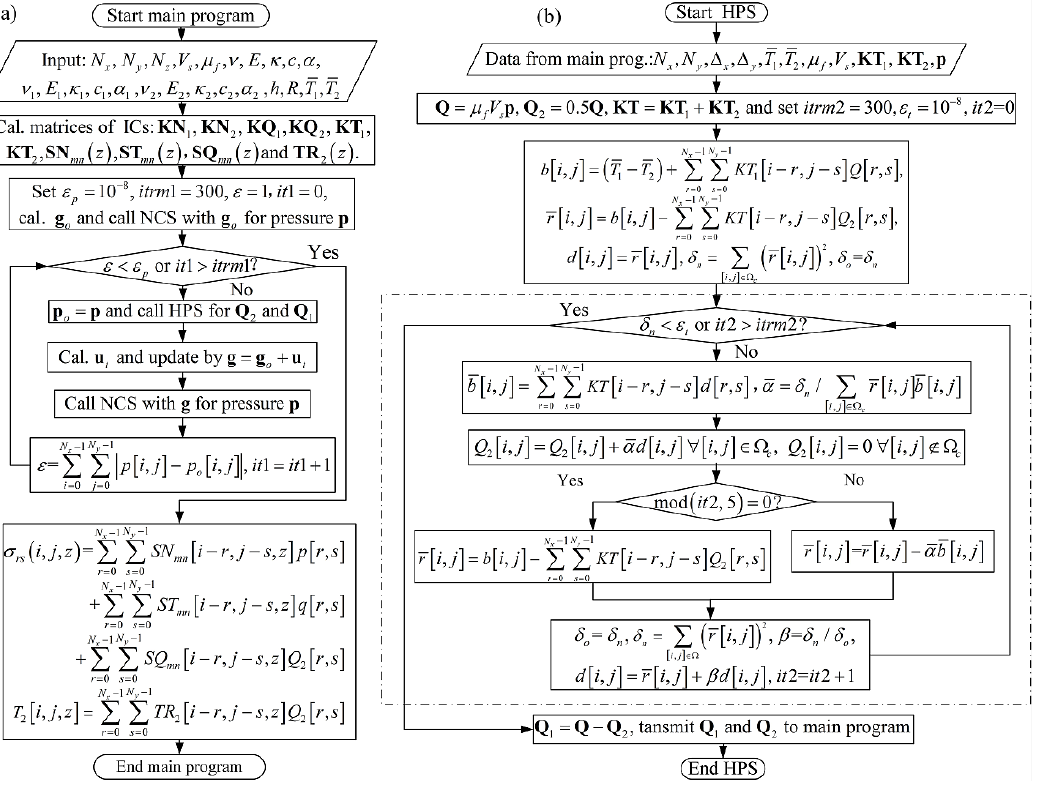
Figure 2. The algorithm flow chart: ( a ) overall flow chart of the thermal elastic contact model, ( b ) flow chart of the heat partition model.